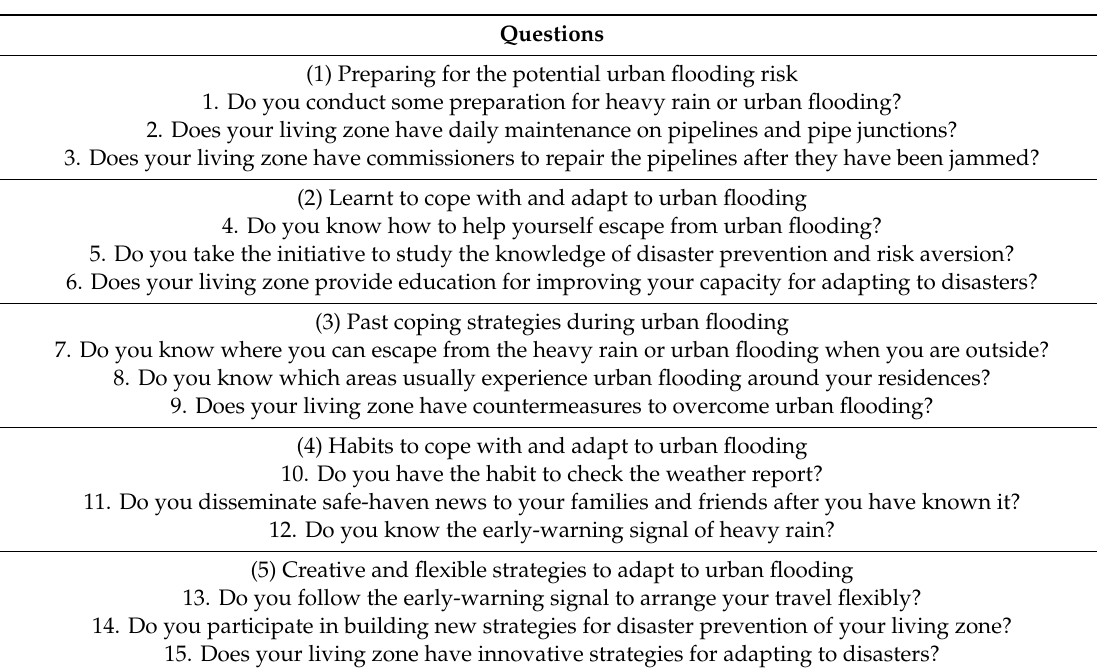
Table 1. Questions for individual